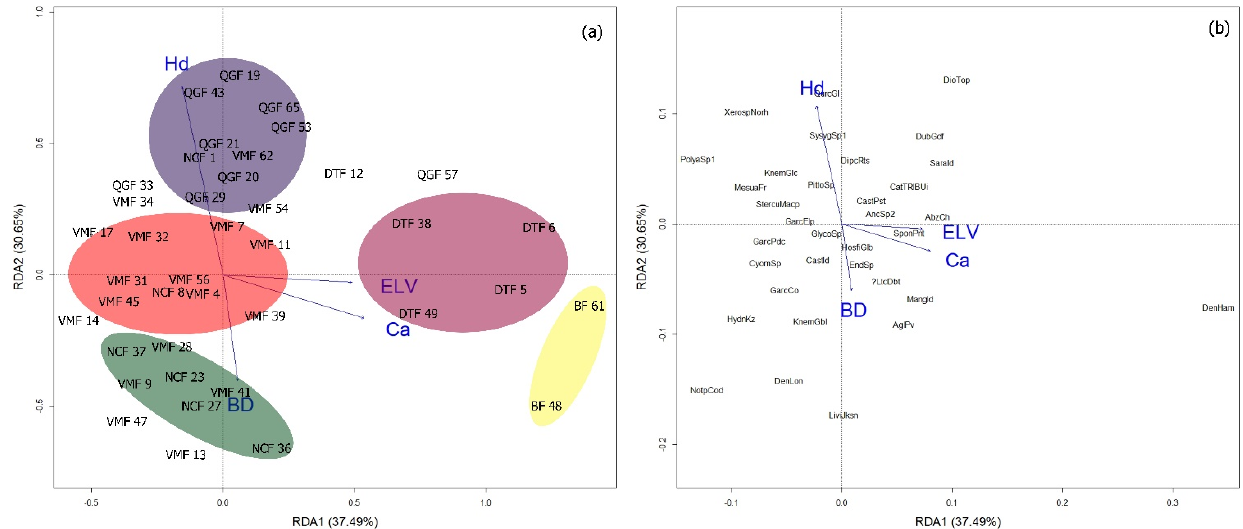
Figure 3. Redundancy analysis (RDA) biplot showing the ( a ) relationship among environmental variables and forest communities and ( b ) relationship among environmental variables and dominant tree species at 15–30 cm soil depth in Htamanthi Wildlife Sanctuary in Myanmar. Abbreviations: ELV—elevation, Hd—soil hardness, Mg—extractable magnesium, Ca—extractable calcium; forest communities: Vatica maingayi forest (VMF), Quercus glauca forest (QGF), Nothaphoebe condensa forest (NCF), and Diospyros toposia forest (DTF). The number after the abbreviated name of the forest community in panel ( a ) indicates the plot number. In panel ( b ), the black lowercase letters indicate the abbreviated scientific names of dominant tree species (Table S1).